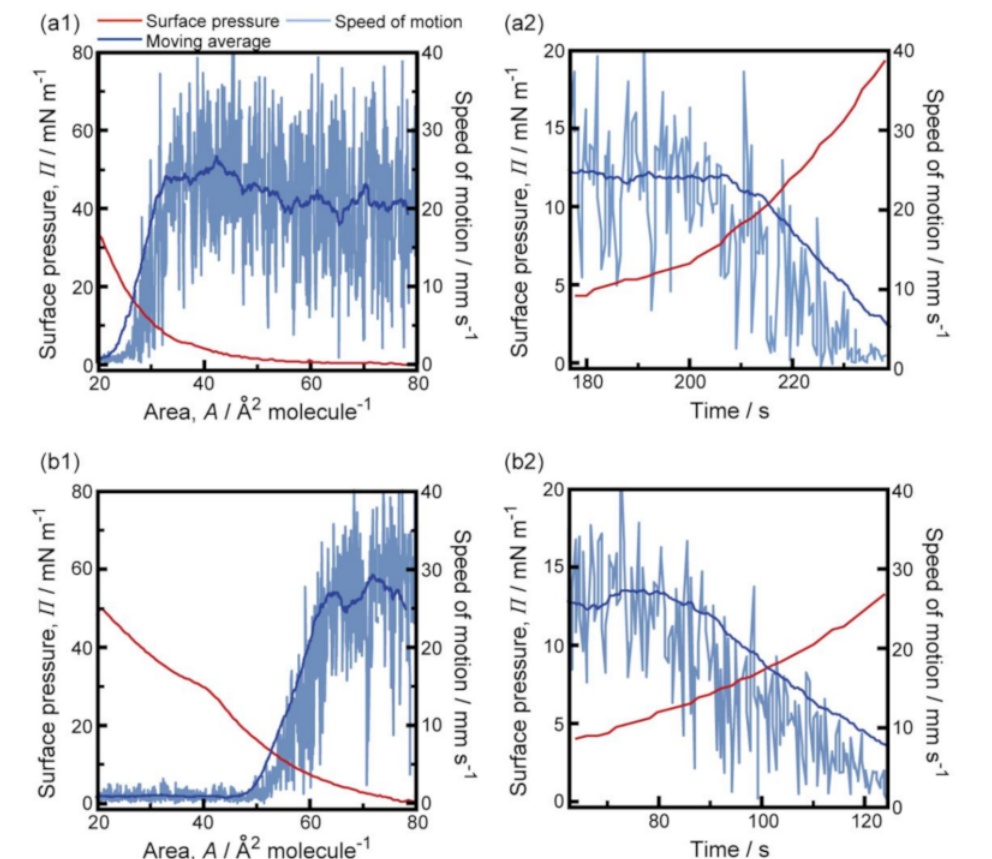
Figure 4. ( a1 , b1 ) Dependence of surface pressure (red lines) and moving average speed of the camphor disk (blue lines) on molecular area of MANA ( a1 ) and OPANA ( b1 ) at 323 K. Pale blue lines represent actual speeds of the camphor disk; ( a2 , b2 ) time variations of surface pressure and speed of a camphor disk on the MANA ( a2 ) and OPANA ( b2 ) molecular area at 323 K magnified around the condition of β (4 ≤ Π ≤ 20 mN m − 1 ). Reproducibility was certified by more than three